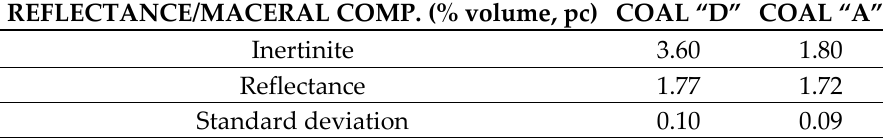
Table 1. Reflectance of the two types of coal “D” and “A”.